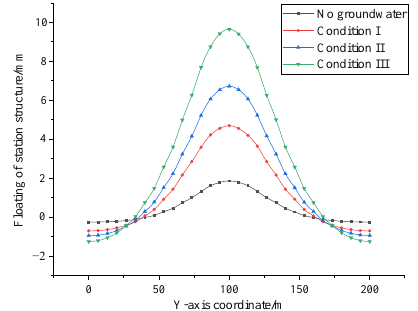
Figure 5. Deformation curve of existing station.